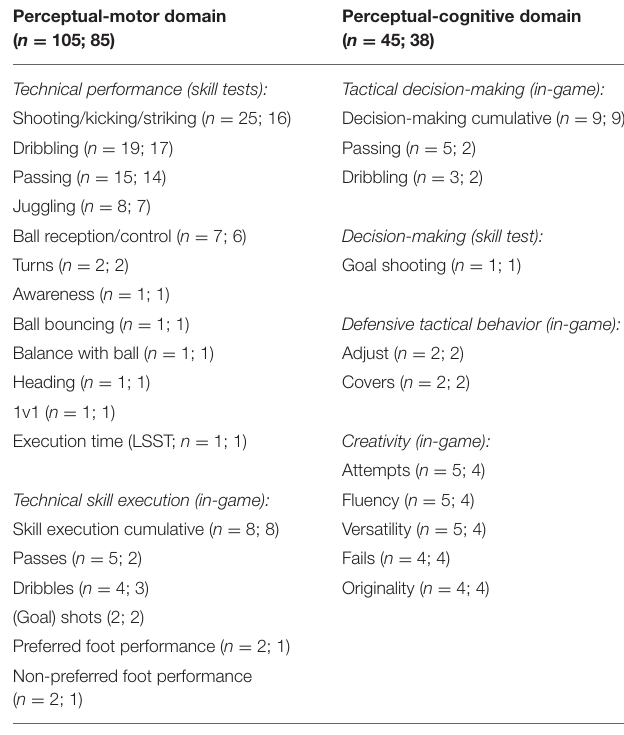
TABLE 4 | Soccer-specific outcome variables ( n = 150) from perceptual-motor and perceptual-cognitive skill domains. Perceptual-motor domain ( n = 105; 85)